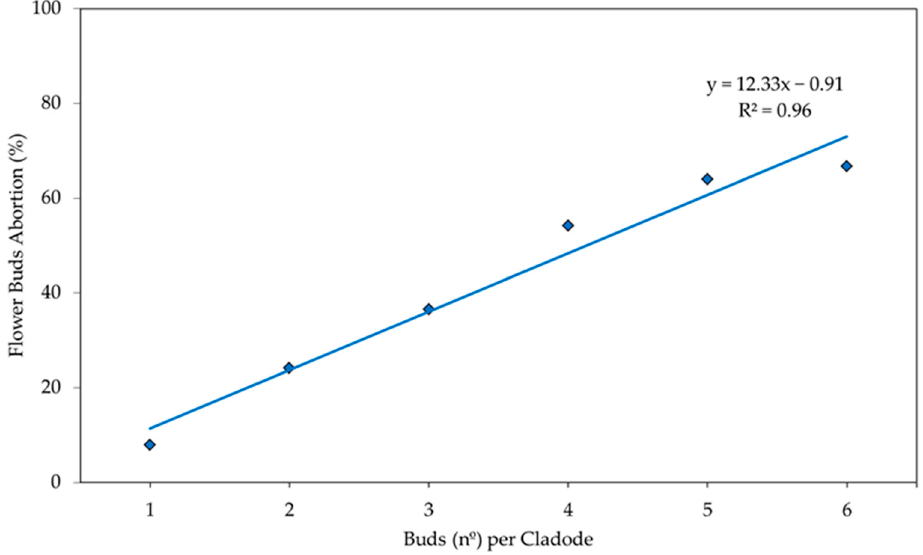
Figure 5. Flower buds abortion in relation to flowering intensity at cladode level.